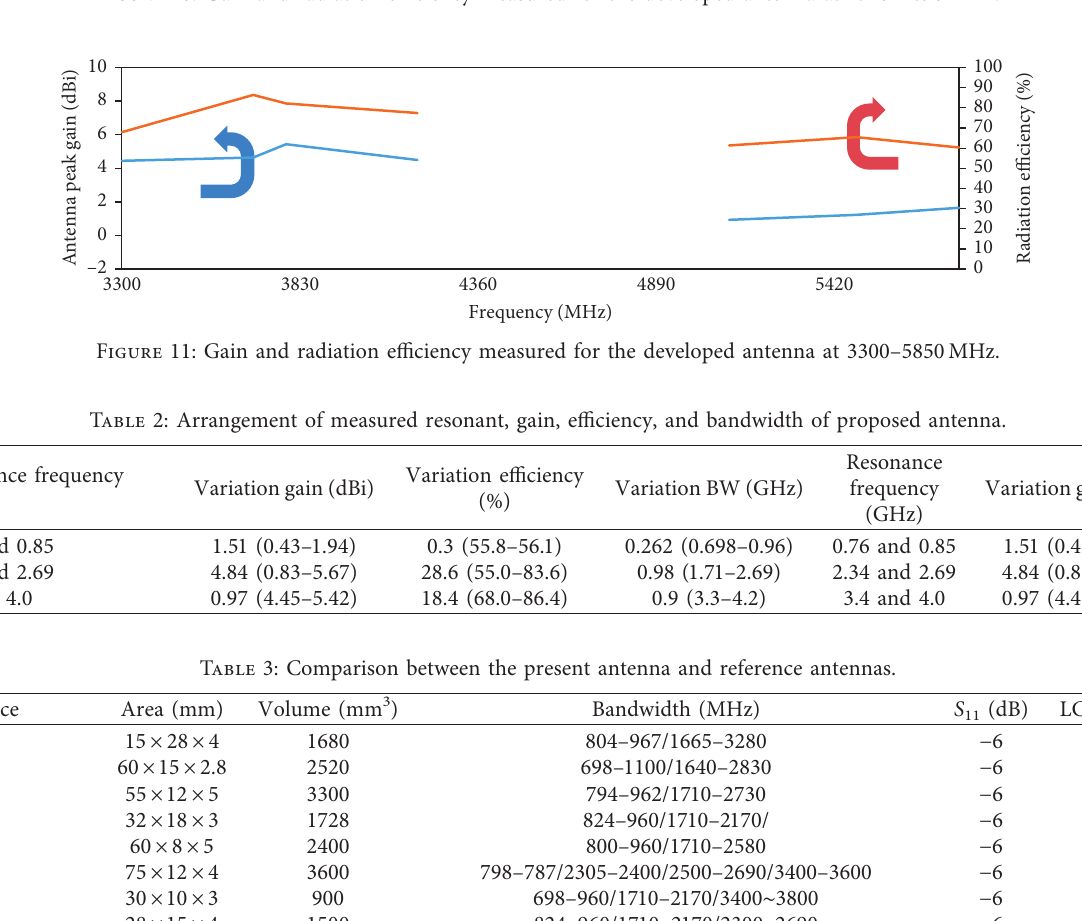
Figure 10: Gain and radiation efficiency measured for the developed antenna at 1710–2690MHz.